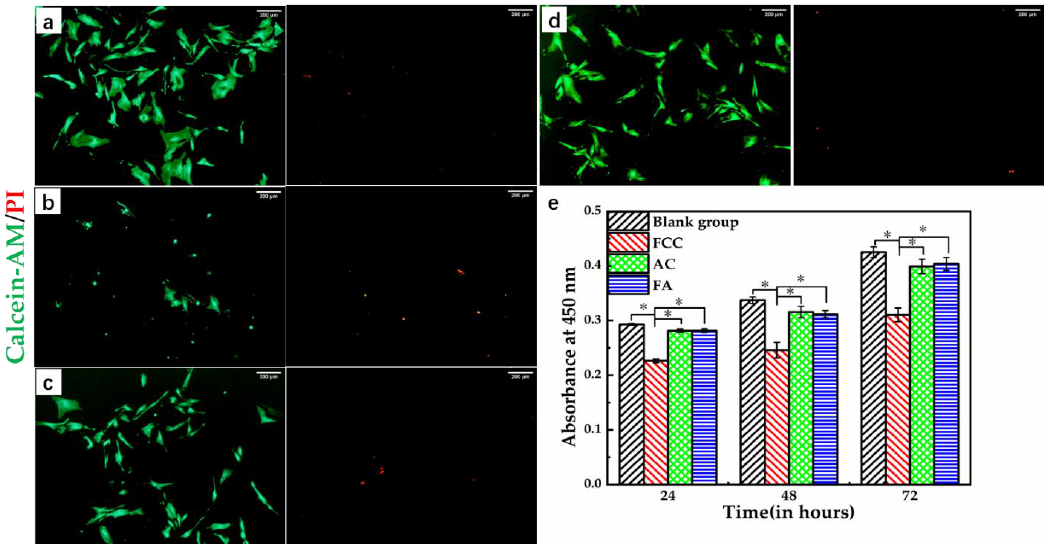
Figure 3. The proliferation and growth of DPCs in the extracted media of different scaffolds. The fluorescent staining images of live-dead cells after 3-day of culturing in: ( a ) blank, ( b ) FCC, ( c ) AC, ( d ) FA extract, respectively. Live cells showed green, and dead cells showed red. ( e ) The cell proliferation after 24, 48, and 72-h culture in the extracted media of different scaffolds tested using CCK-8. * indicates statistically significant differences. (n = 4, per group, p < 0.05.) Scale bars = 200 μm.